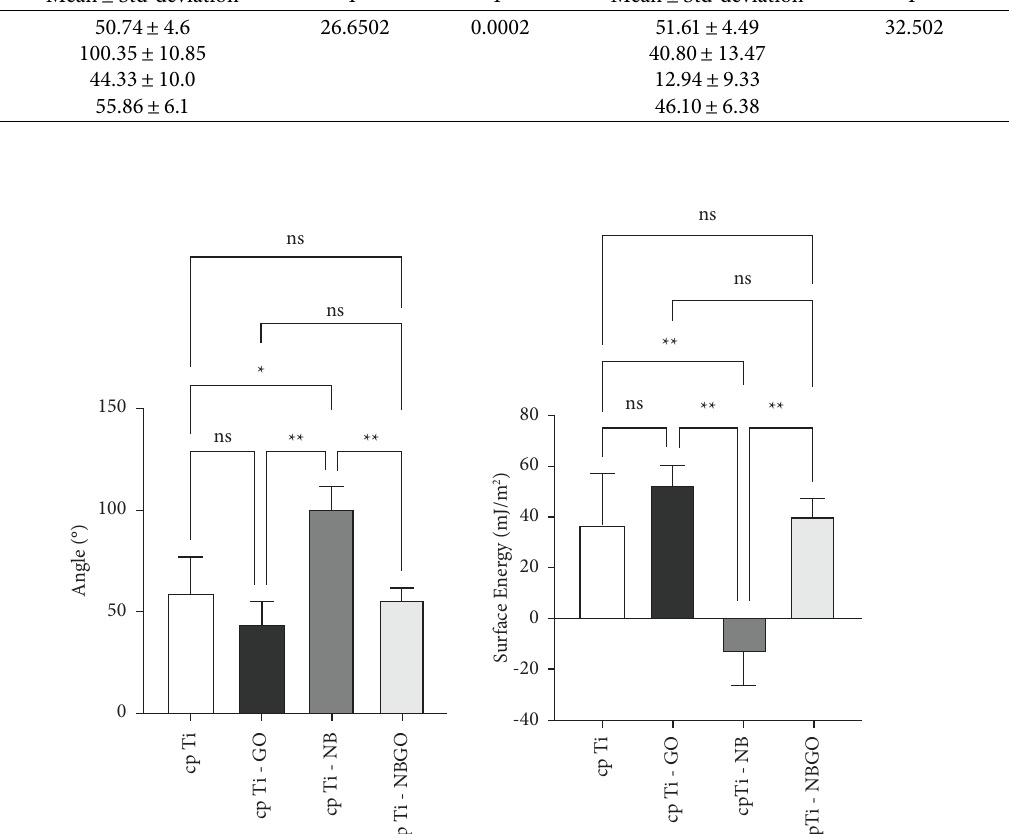
Figure 6: Tukey test results for wettability